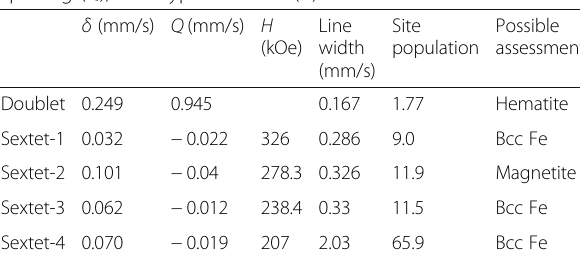
Table 2 Mössbauer parameters, isomer shifts ( δ ), quadrupole splitting ( Q ), and hyperfine field ( H ) of Fe NCs-0.